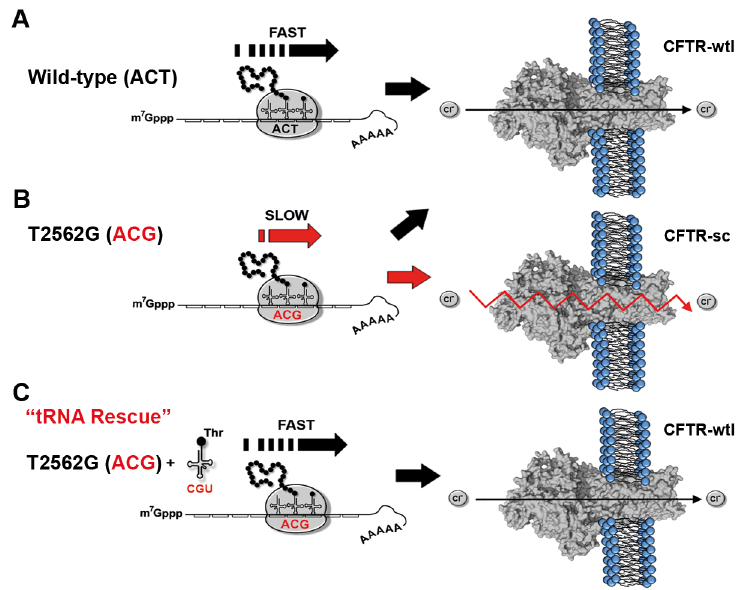
Fig 6. The synonymous single nucleotide polymorphism (sSNP) T2562G inverts local translation speed in CFTR mRNA, which can be rescued by tRNA Thr (CGU). ( A ) Thr-854–encodingcodon ACT in wild-typeCFTR is translated fast, as its cognatetRNA Thr (AGU) is relativelyabundant.( B ) T2562G sSNP converts the ACT triplet to ACG codon, which is read by the rare cognatetRNA Thr (CGU) and reduceslocal ribosomal speed. Stochasticity in the delivery of tRNA Thr (CGU) cognate to the ACG codon creates variations in the intimate translation speed of each ACG codonat this positionand hence generates 2 distinct CFTR channelpopulations,one with wild-type–like (wtl) CFTR propertiesand a second with a reducedconductance and a more compact structure (small-conductance[sc] population). ( C ) Increase of the cellularlevel of tRNA Thr (CGU) pairing to the mutated ACG codon restores ribosomespeed at the rare Thr-ACG codon and rescues the CFTR conductance defect.